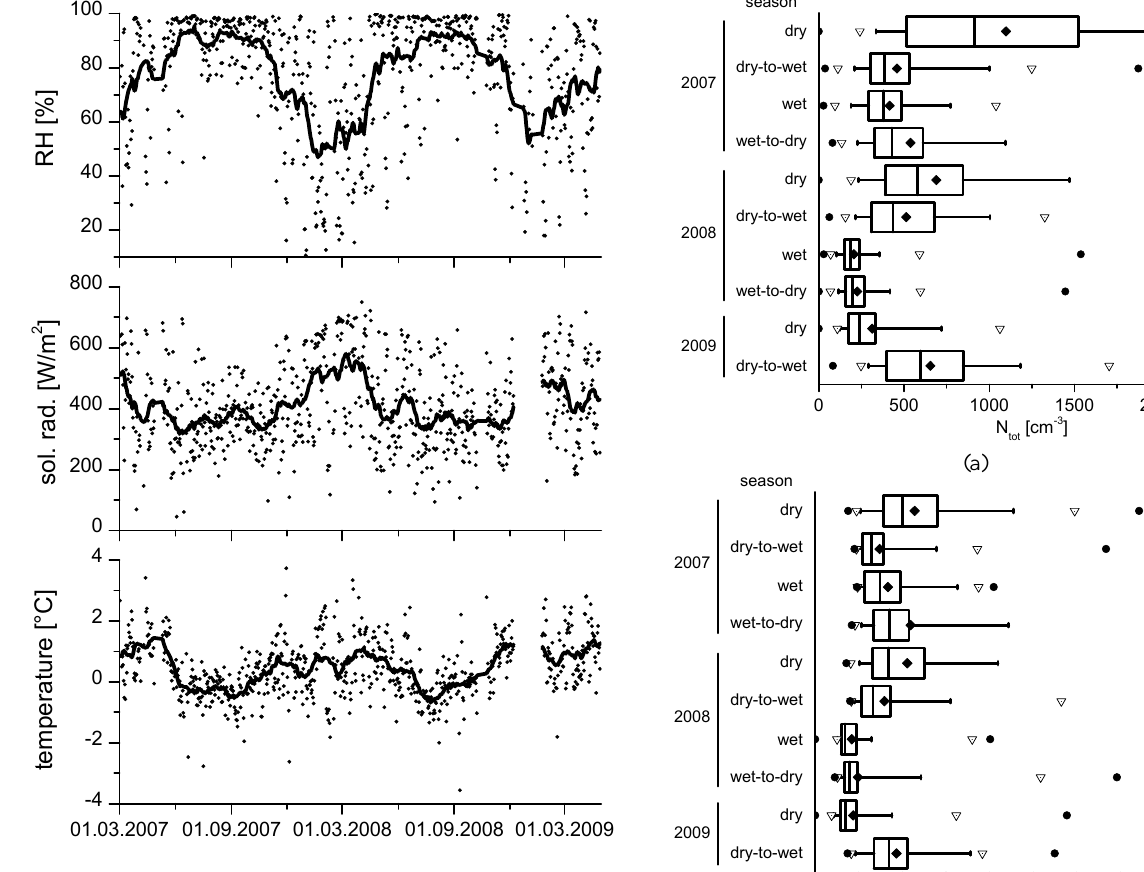
Fig. 1. Multi-annual time history of relative humidity, solar radia- tion and temperature at Pico Espejo. Dots represent daily averages, lines 30-day moving averages. Solar radiation was averaged for the illuminated part of the day only.